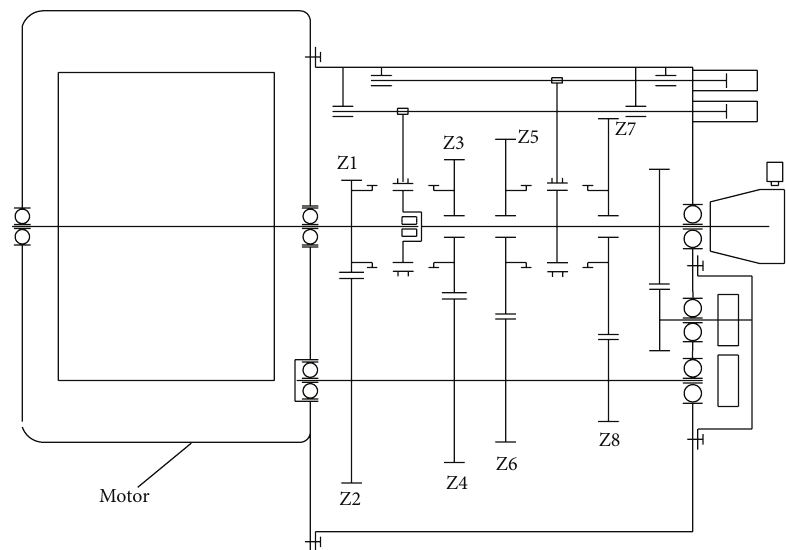
Figure 2: Configuration of the four-gear